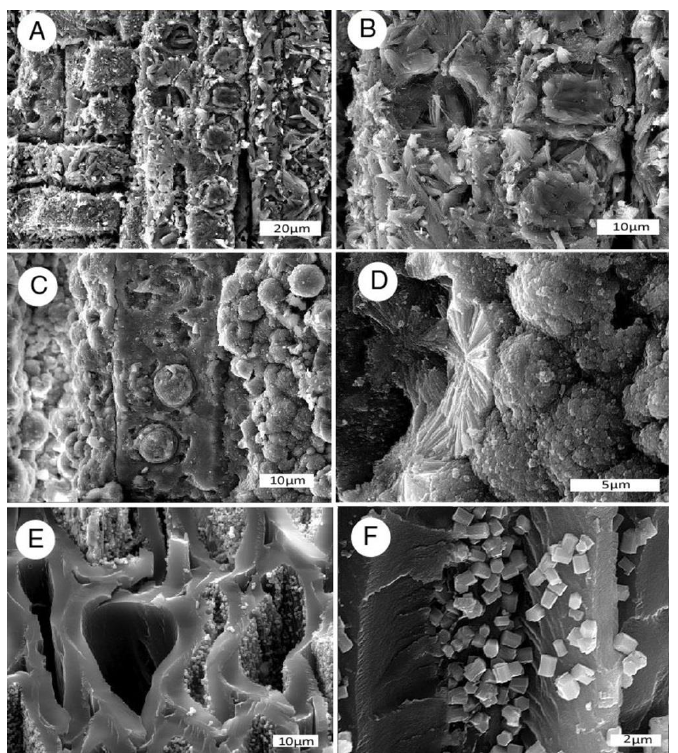
Figure 7. Phosphatized wood. ( A , B ) carbonate-fluorapatite, Virgin Valley, Nevada USA, Miocene, radial view; ( C , D ) fluorapatite, Santa Fe River, Florida USA, Neogene, radial view; ( E,F ) small euhedral apatite crystals on cell walls in carbonized wood, Yuba River, Nevada County, California USA, Eocene, ( E ) oblique transverse view, ( F ) radial view.